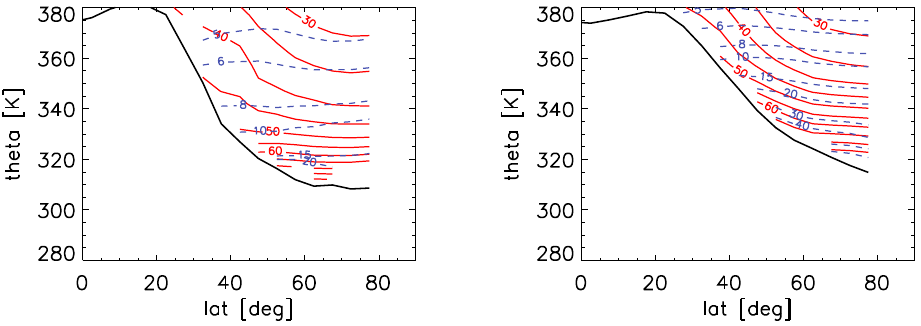
Fig. 1. Zonal mean distribution of H 2 O (blue dashed lines, in ppmv) and CO (red solid lines, in ppbv) on isentropes for northern winter (November, December, January, NDJ) (left) and summer (May, June, July, MJJ), respectively, as observed from the ACE-FTS instrument, black line denotes the tropopause. Only stratospheric observations with O 3 > 200 ppbv were used. Note that CO isopleths are tilted against the quasi-isentropic water vapour isopleths.